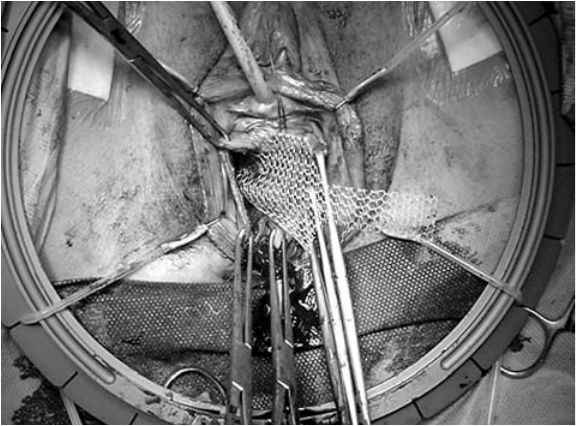
Figure 1 – Surgical technique of cistocele repair with mesh. Mesh placement, positioning the tabs in paravaginal spaces, tension free, without stitches.